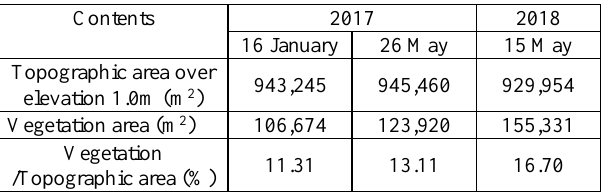
Table 1. Variation of topographic change area and semi-auto classification of Jinu-do between 2017 and